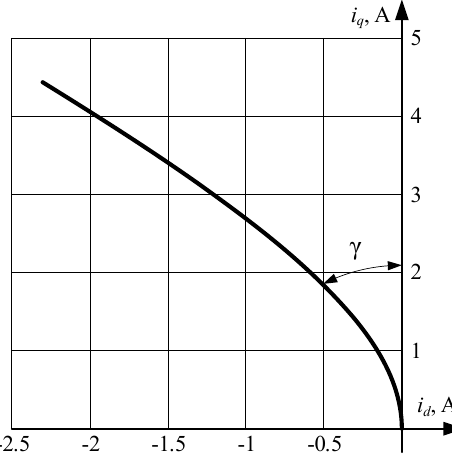
Figure 2. MTPA trajectory in i d i q plane.